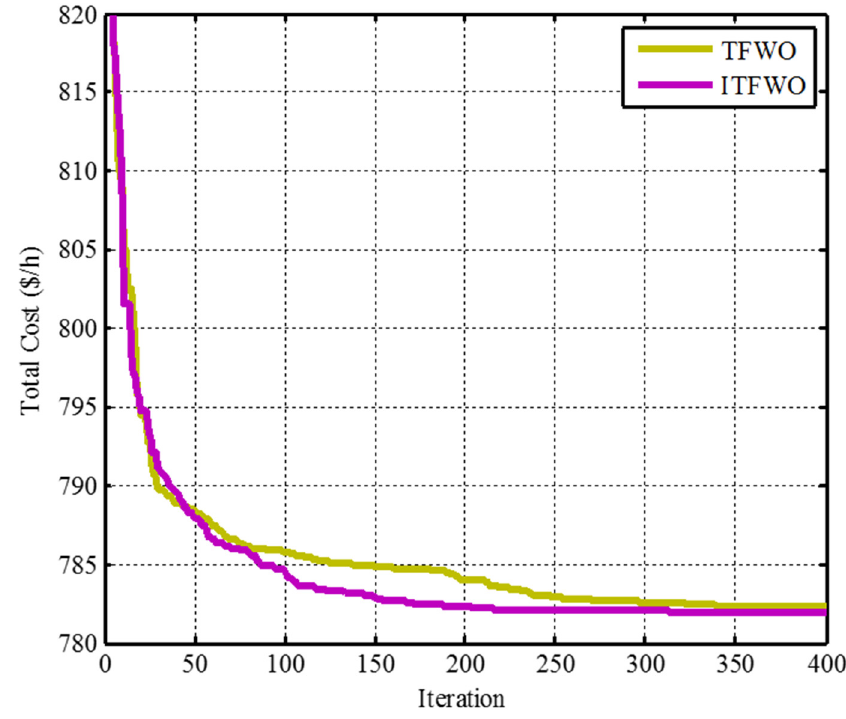
Figure 9. Optimization process for Type 7. Table 9. The optimization results for Type